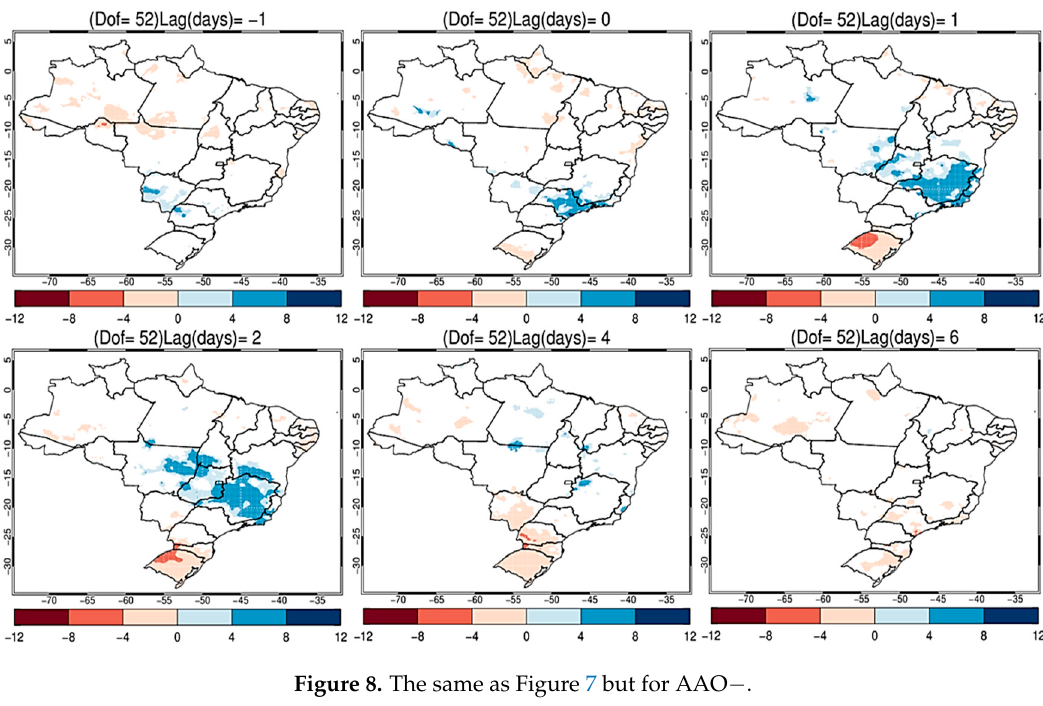
Figure 8. The same as Figure 7 but for AAO–.